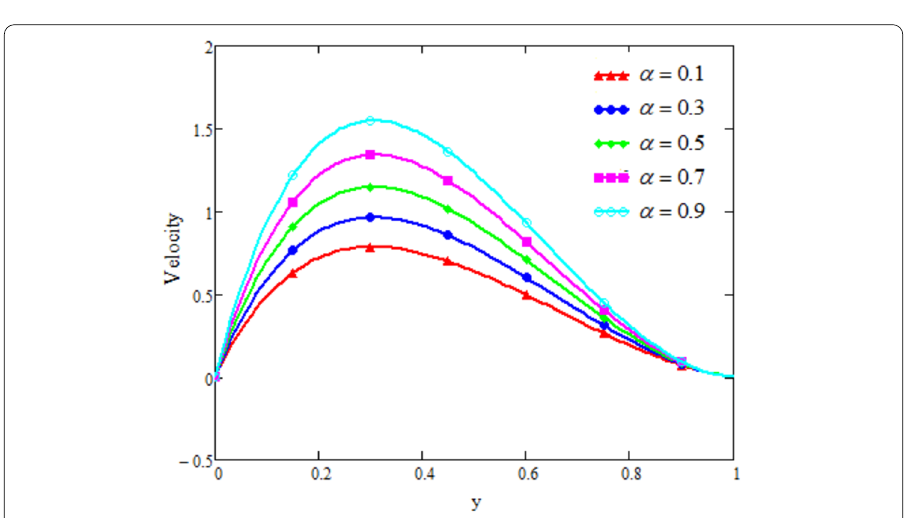
Figure 5 Velocity curves along α variation and P r = 15, G r = 15.5, K = 12.5, λ = 1.9, λ 1 = 1.6, H a = 0.8, t =